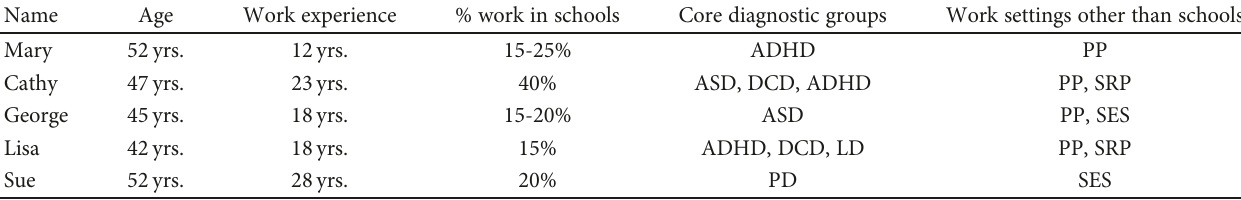
Table 1: Description of